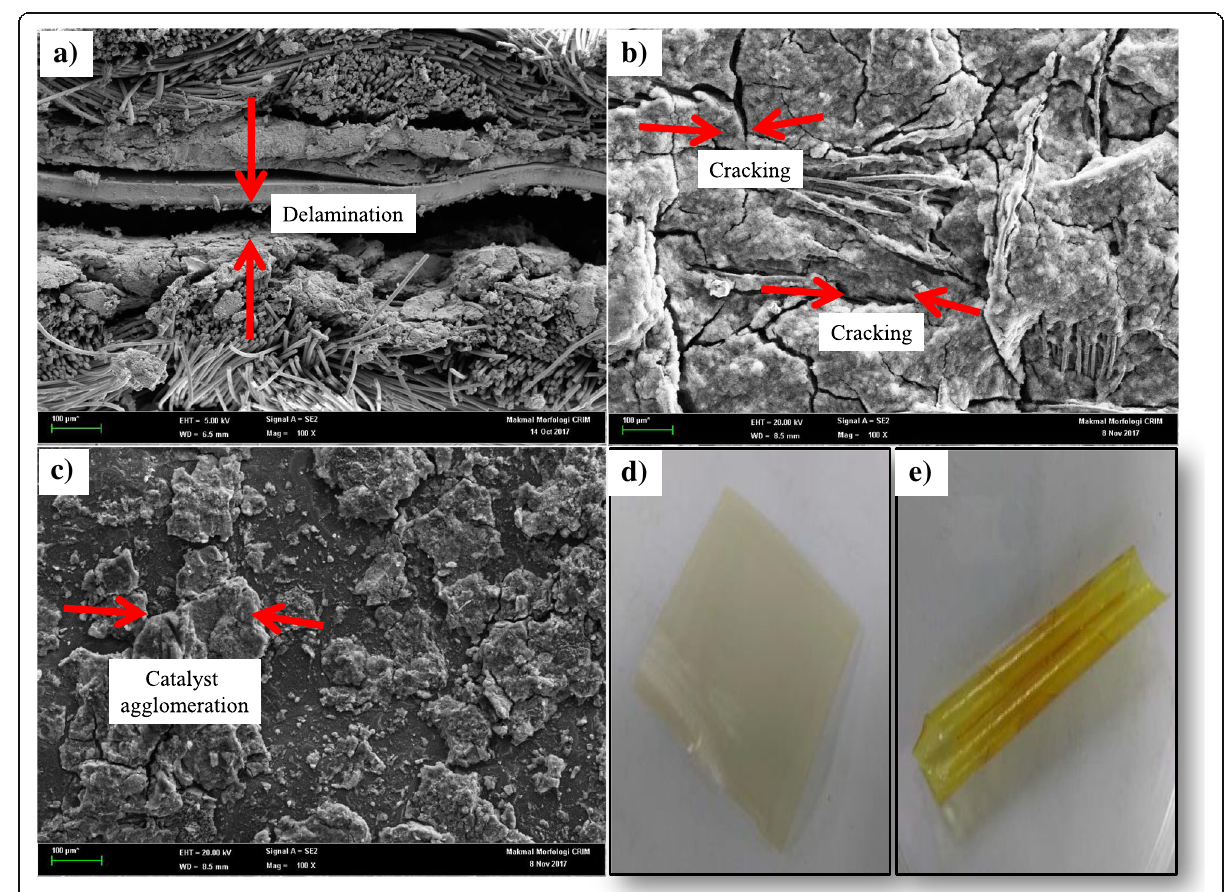
Fig. 10 a Delamination. b MPL cracking. c Catalyst